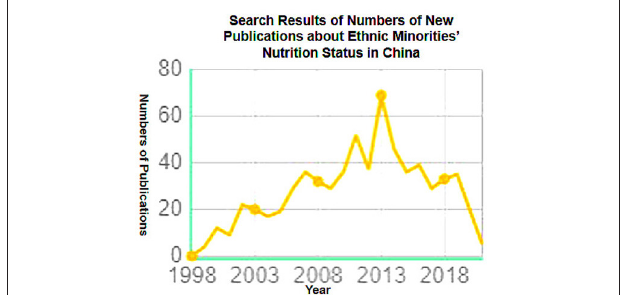
FIGURE 1 | The distribution of publications of nutrition status among ethnic minority groups in China from 1998 to 2021 (generated by Wanfang Med